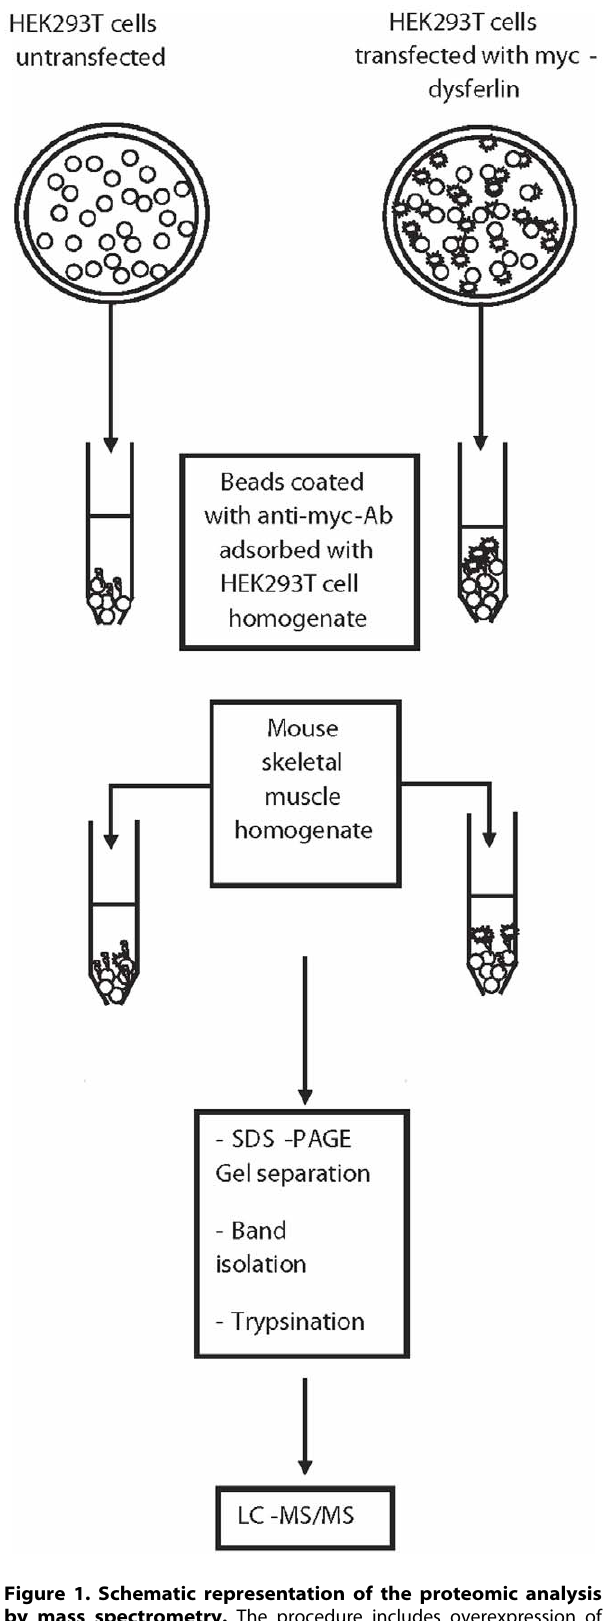
Figure 1. Schematic representation of the proteomic analysis by mass spectrometry. The procedure includes overexpression of His-myc-dysferlin in HEK293T cells, purification on protein A-Sepharose beads coupled to anti-myc antibody, incubation of the